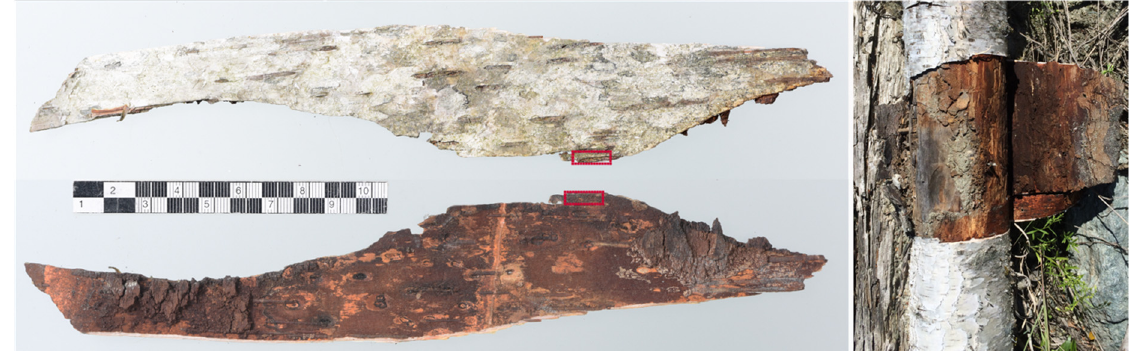
Figure 3. Birch bark fragment harvested from fallen trunk degraded in nature. Outer surface, especially when in contact with the ground, shows green, grey and brown discoloration and vertical cracks. Lenticels have cracks and overlays and are areas no longer clearly defined. On the inner side, remains of brittle and brown-black stained phloem are present and black circular deposits indicate areas of increased degradation. Location of analysed sample 0 is indicated with red rec- tangle.